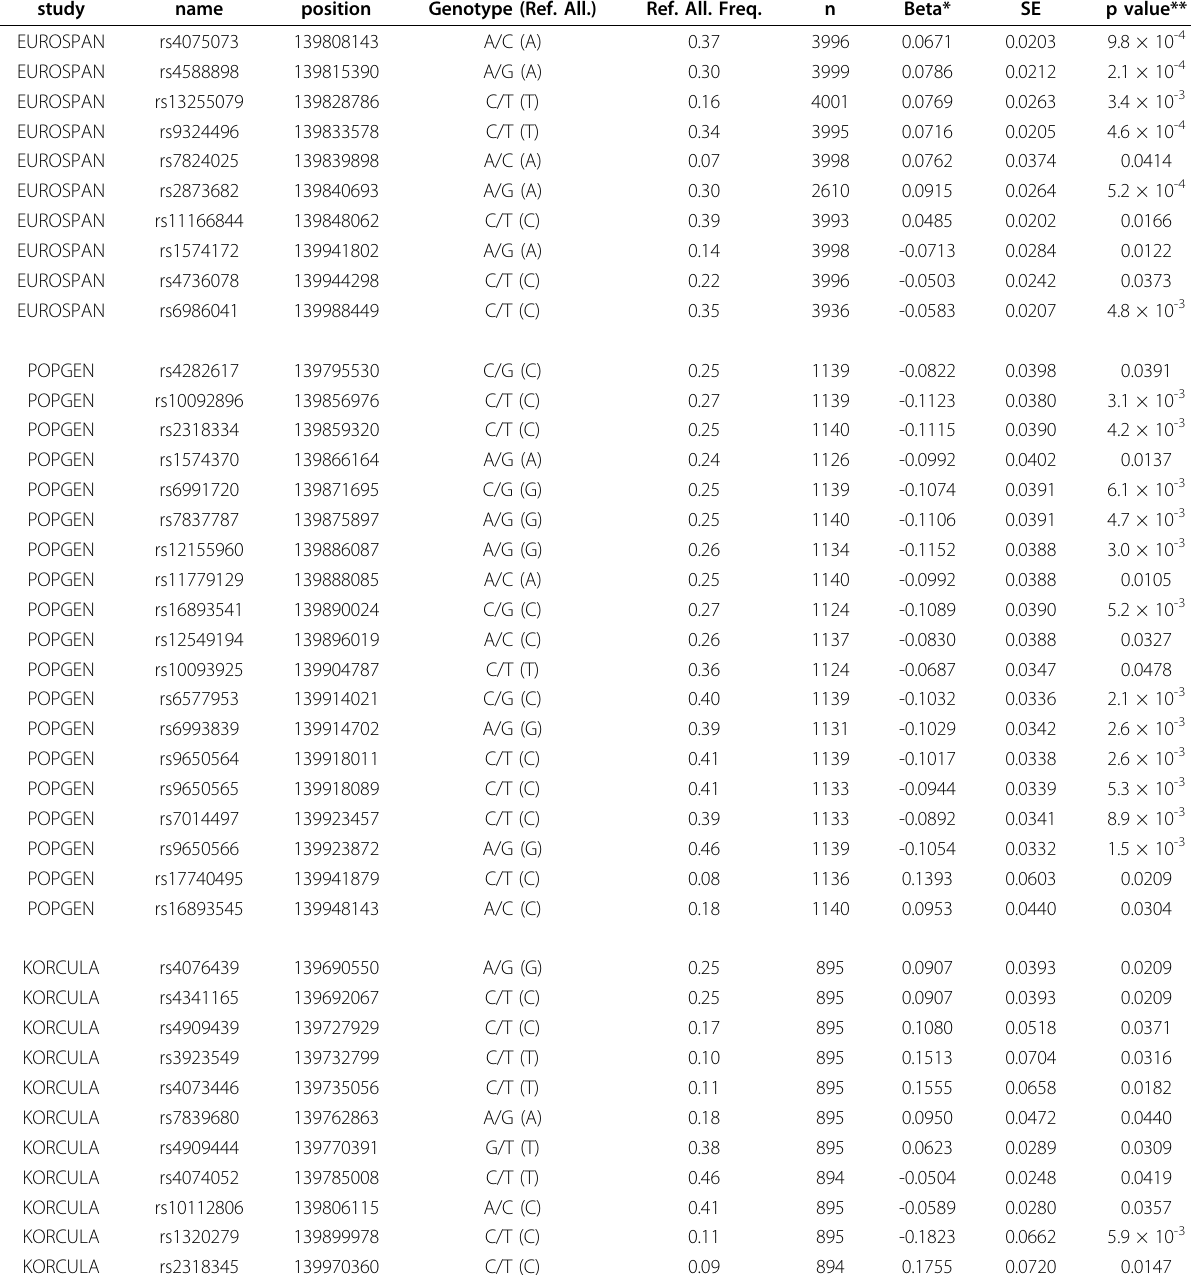
Table 2 SNPs showing the highest evidence of association in the COL22A1 gene (chromosome 8). #